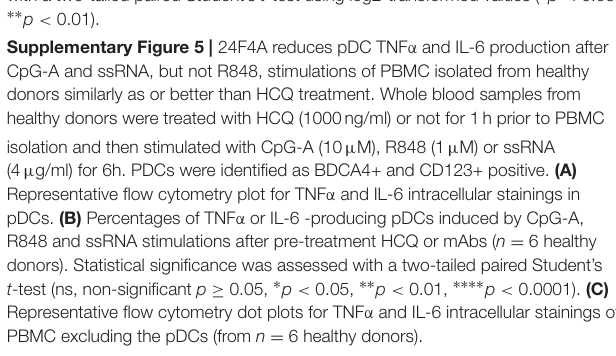
Supplementary Table 1 | Effect of 24F4A on pDC IFNs production after CpG-A or R848 stimulations of PBMC isolated from CLE patients regardless blood HCQ